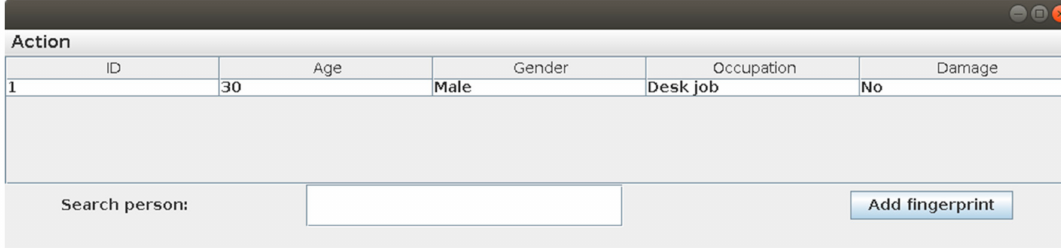
Figure 3. Application form for entering new users.